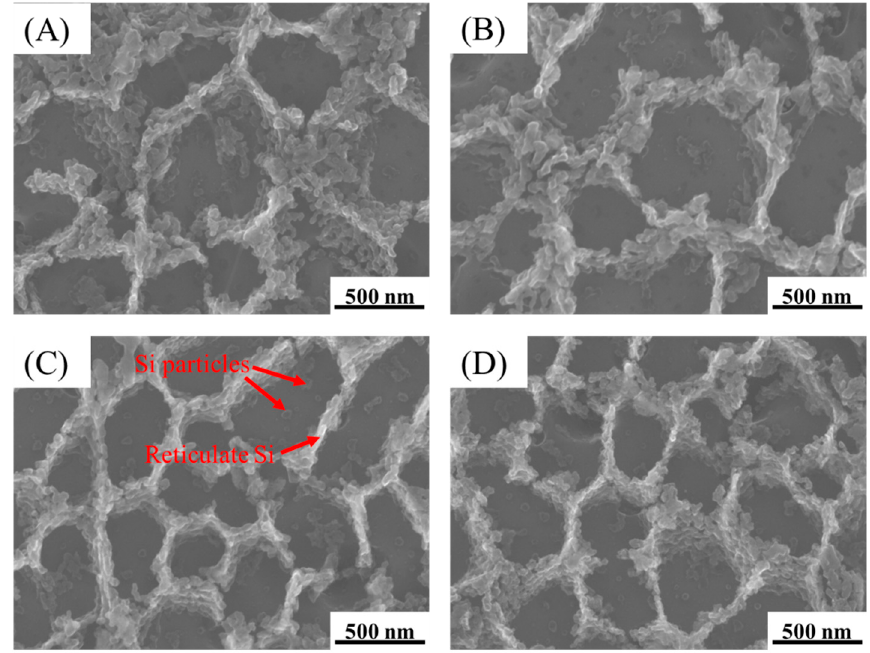
Figure 11. The microstructure morphology of the samples treated by deep ‐ etching: ( A ) Process A2;